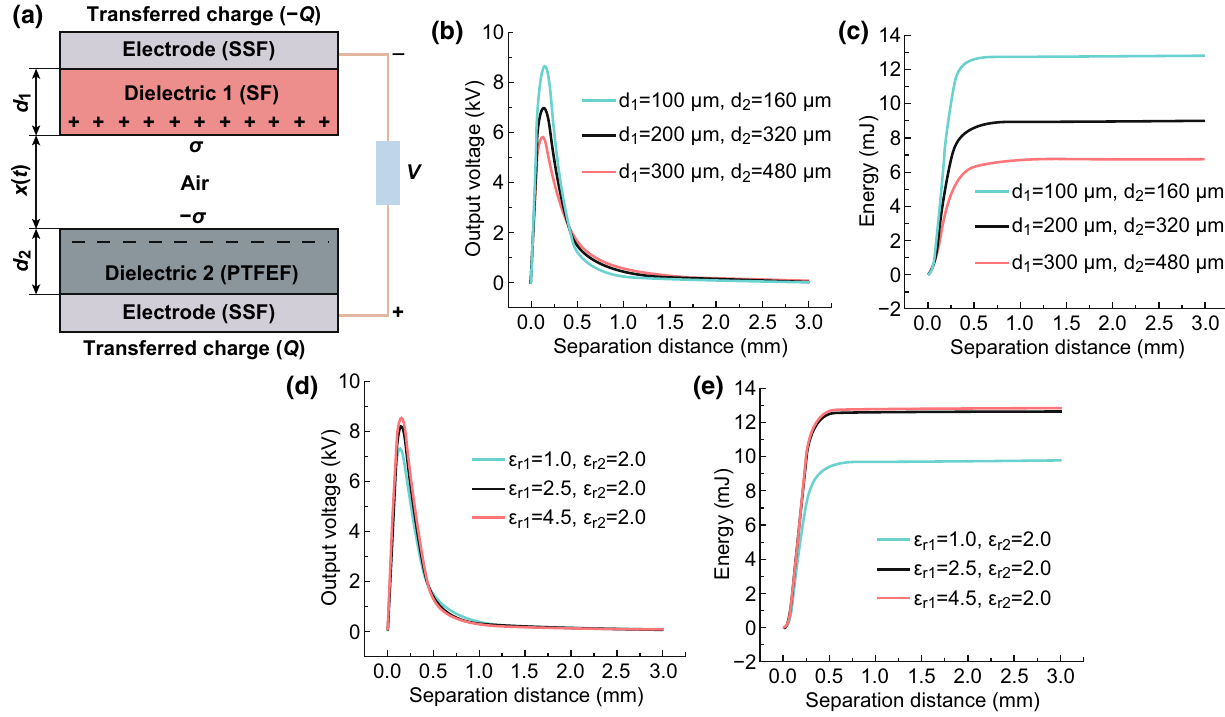
Fig. 4 Structure of EHT theoretical model and effect of thickness and relative permittivity on real-time output voltage and energy: a Simplified structure of SF/PTFEF EHT. b , c Influence of thickness of SF ( d 1 ) and PTFEF ( d 2 ) on the output voltage and energy of SF/PTFEF EHT, respec- tively. d , e Influence of relative permittivity of SF ( ε r 1 ) on the output voltage and energy of SF/PTFEF EHT,